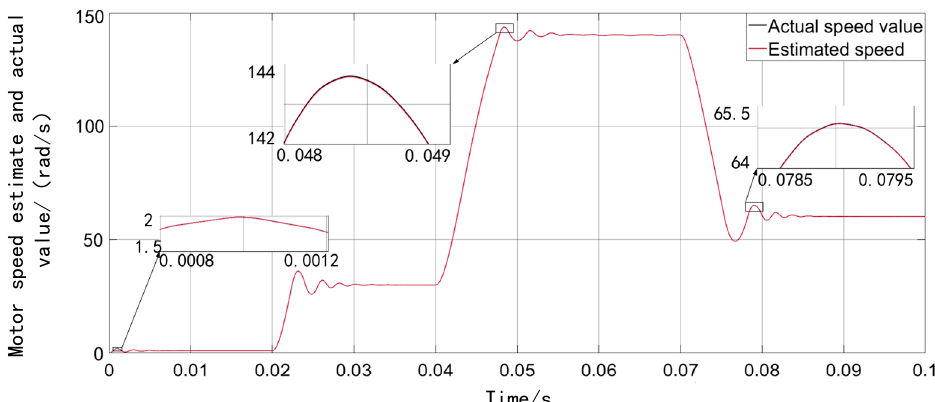
Figure 19. The motor speed comparison chart of the new and improved SMO at full speed.